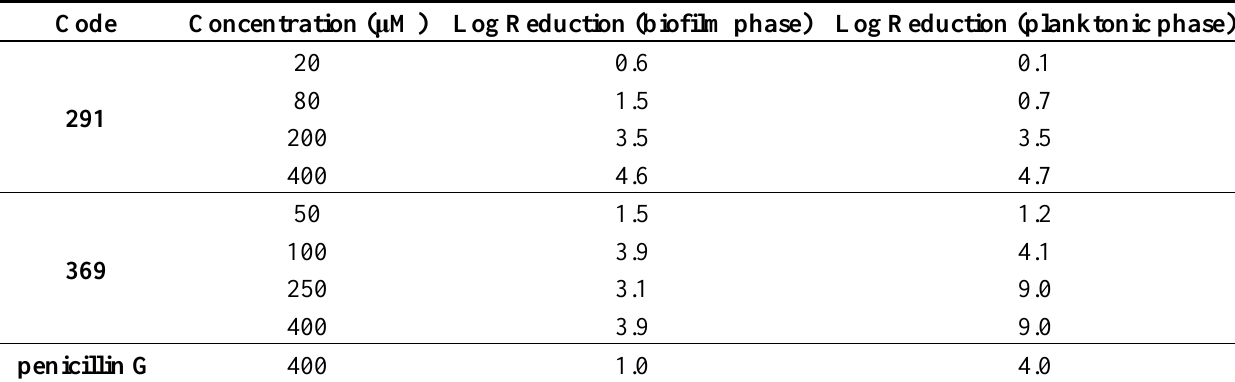
Table 3. Killing efficacy of flavans 291 and 369